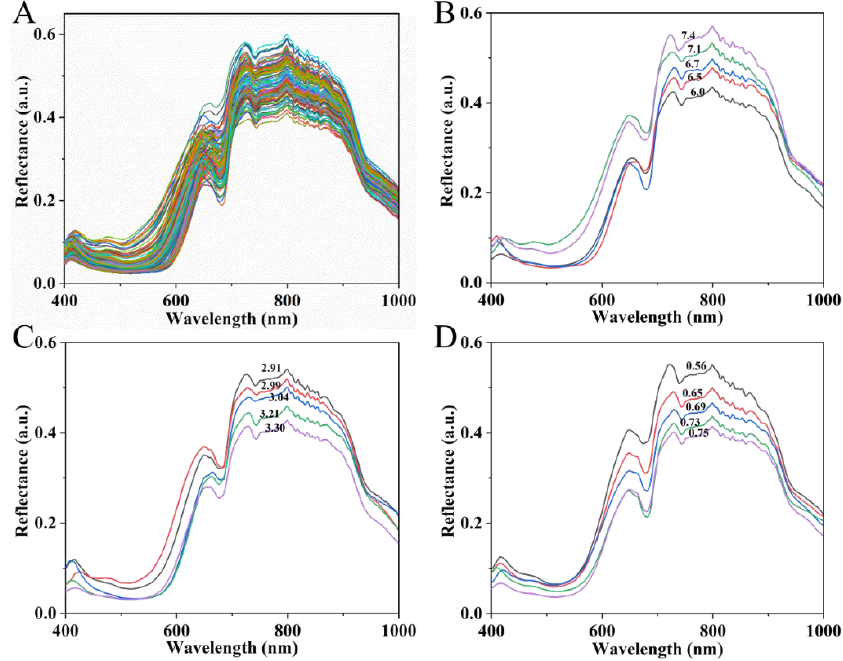
Figure 2. Reflectance spectra of strawberries. Spectra of 120 strawberries ( A ) and spectra of strawberries of different SSCs ( B ), pH ( C ), and VC ( D ) contents.